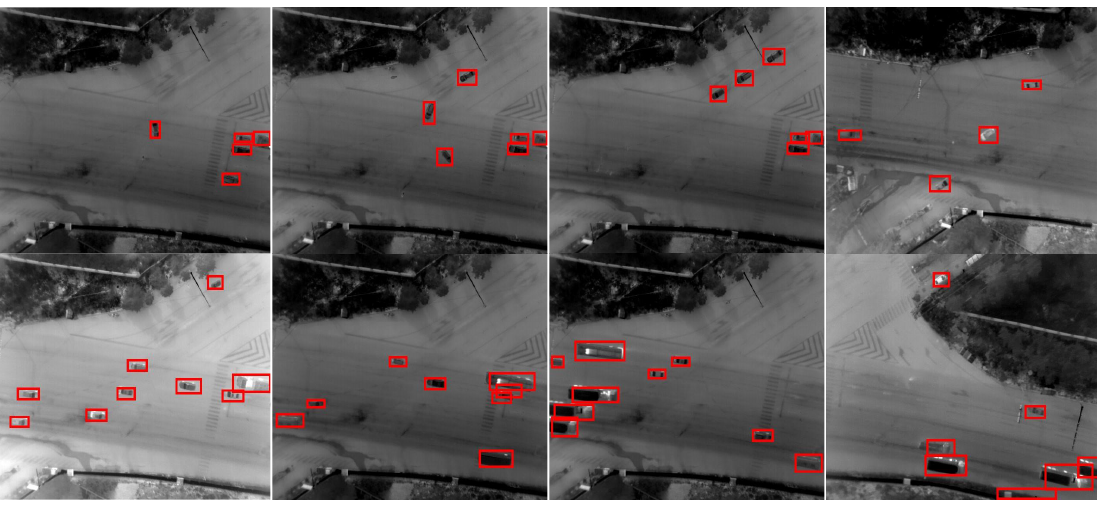
Figure 7. The performances of the method on part images of NPU_DJM100_1 [35].